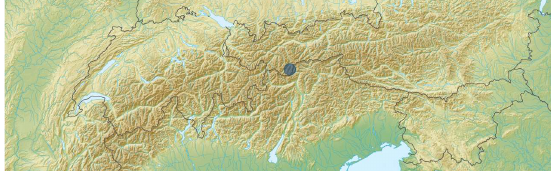
Figure 1. Location of the summer school venue Obergurgl (Austria) in the Alpine context (modified Alps location map by Map Lab CC BY